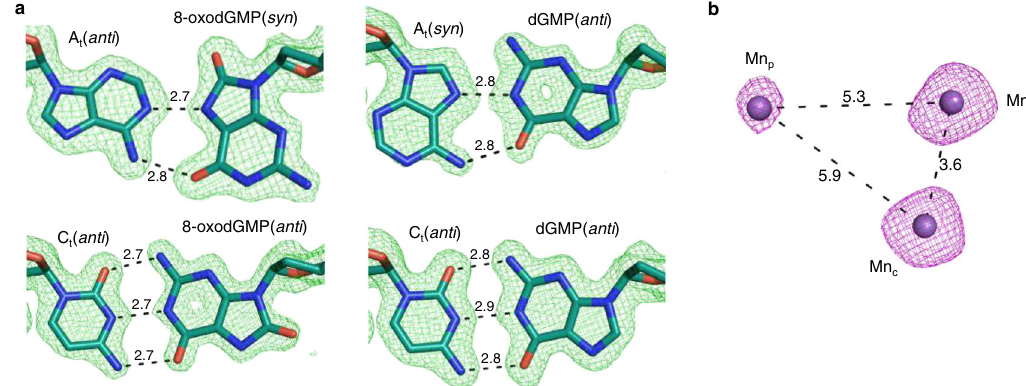
Fig. 5 Active site dynamics. a Base-pair hydrogen bonding is retained post-catalysis. Hydrogen bonding with the template base in the 960 min Mn 2 + soaks of the 8-oxodGMP( syn ):A t ( anti ) (PDB id 7KT6), 8-oxodGMP( anti ):C t ( anti ) (PDB id 7KTD), dGMP( anti ):C t ( anti ) (PDB id 7KSV), and the dGMP( anti ): A t ( syn ) (PDB id 7KT2) product complexes are shown with black dashes and distances (Å) labeled. DNA is shown in cyan stick representation. F o – F c density (green mesh) shown is contoured at 3.0 σ , carve radius 2.0 Å. b Product metal supports catalysis at sub-physiological Mn 2 + concentrations (PDB id 7KTI). Ground state Ca 2 + :8-oxodGTP( anti ):C t ( anti ) ternary complex crystals were soaked in a cryo solution containing 20 μ M Mn 2 + for 120 min. Full product formation has occurred. Anomalous map (purple mesh, contoured at 4 σ ) displays density for Mn p . Distances between metal atoms are shown with dashes and distances (Å) are